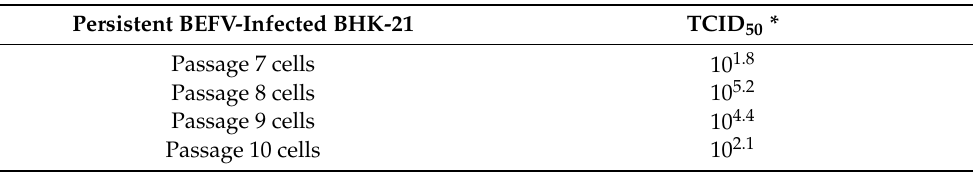
Table 1. Virus titer of the persistent BEFV-infected BHK-21 cells.